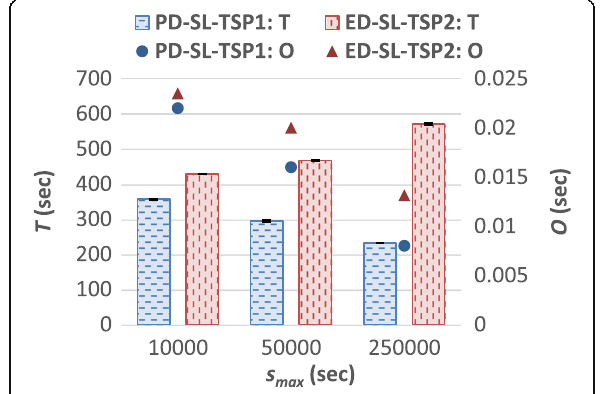
Fig. 9 Effect of s max on T and O when using the CyberShake